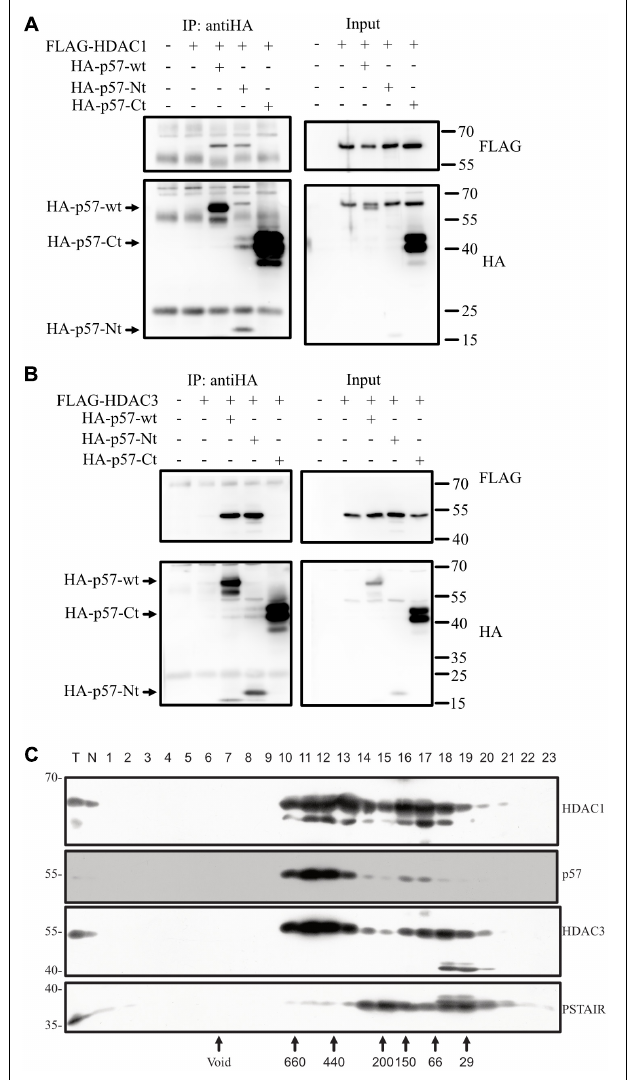
FIGURE 5 | p57 binds HDAC1 and HDAC3 via its N -terminal domain and co-migrates in high molecular weight complexes. (A) Co-IP followed by immunoblotting investigating binding of exogenous p57 and domains of p57 to HDAC1. HA-p57, aminoterminal (HA-p57-Nt) and carboxyterminal (HA-p57-Ct) domains were expressed in 293 cells together with FLAG-HDAC1. p57 proteins were immunoprecipitated using anti-HA antibodies and the precipitated p57 proteins were detected by using mouse anti-HA antibodies. Coprecipitated HDAC1 was detected with mouse anti-FLAG antibodies (“IP: antiHA”). One percent of protein extract used for immunoprecipitations was loaded onto the same gel and served as an input control (Input). Size of p57 and its domains are indicated by arrows (left) and molecular weight marker is indicated (right). (B) Similar experiment as in (A) with the exception that binding of FLAG-HDAC3 was analyzed. (C) p57 is a component of high molecular weight complexes and coelutes with HDACs. Crude nuclear extracts of HRT-18 cells were applied to size exclusion chromatography. Fractionation by Superdex 200 10/300 GL was followed by SDS-PAGE and Western blotting, using anti-p57 and anti-HDAC1 and HDAC3 antibodies as indicated. Void volume and the elution of molecular weight markers is indicated below. PSTAIR-reactive CDK proteins were detected using monoclonal anti-PSTAIR